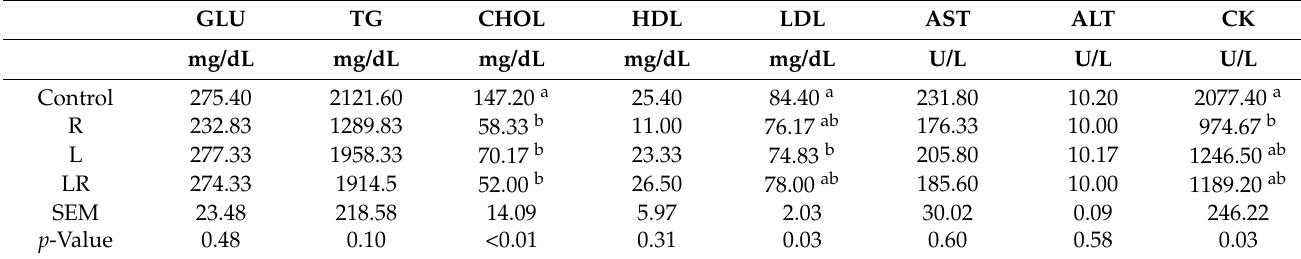
Table 4. Effect of Hydrastis canadensis on blood parameters in laying